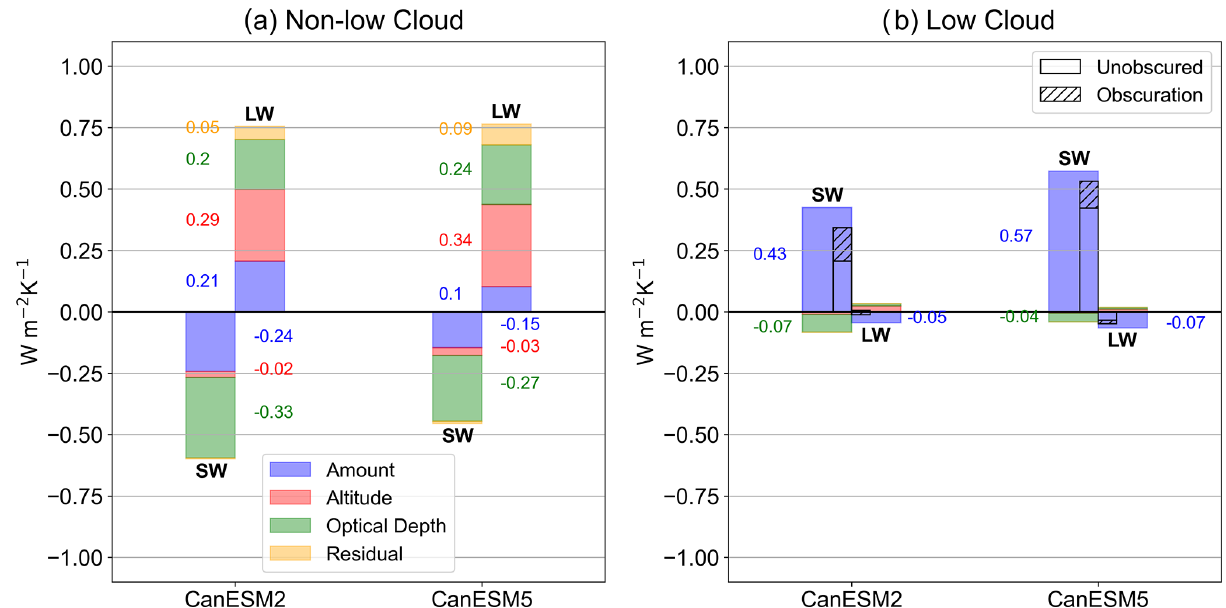
Figure 2. Global annual mean decomposed cloud feedbacks for CanESM2 and CanESM5. Feedbacks are partitioned into both LW and SW contributions from cloud amount (blue), cloud altitude (red), optical depth (green), and residual (orange) terms for non-low (a) and low clouds (b) . Low-cloud feedbacks are also separated into non-obscured and obscuration terms using black bars in panel (b) . For contributions smaller than 0.01Wm − 2 K − 1 , text values were omitted for the sake of